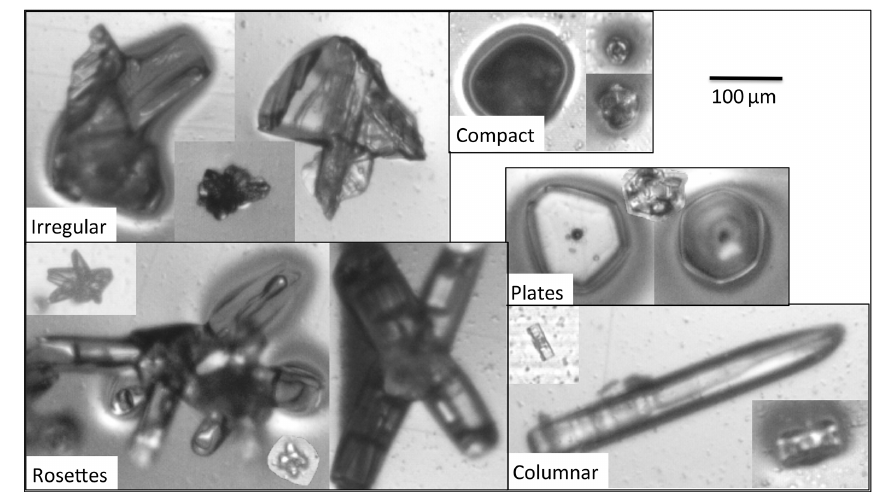
Figure 2. Classification of the different particles into five shape groups: compact, irregular, columnar, plates and